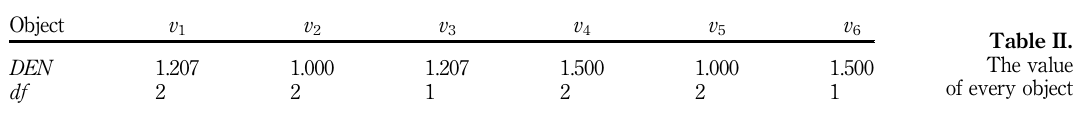
distance between objects